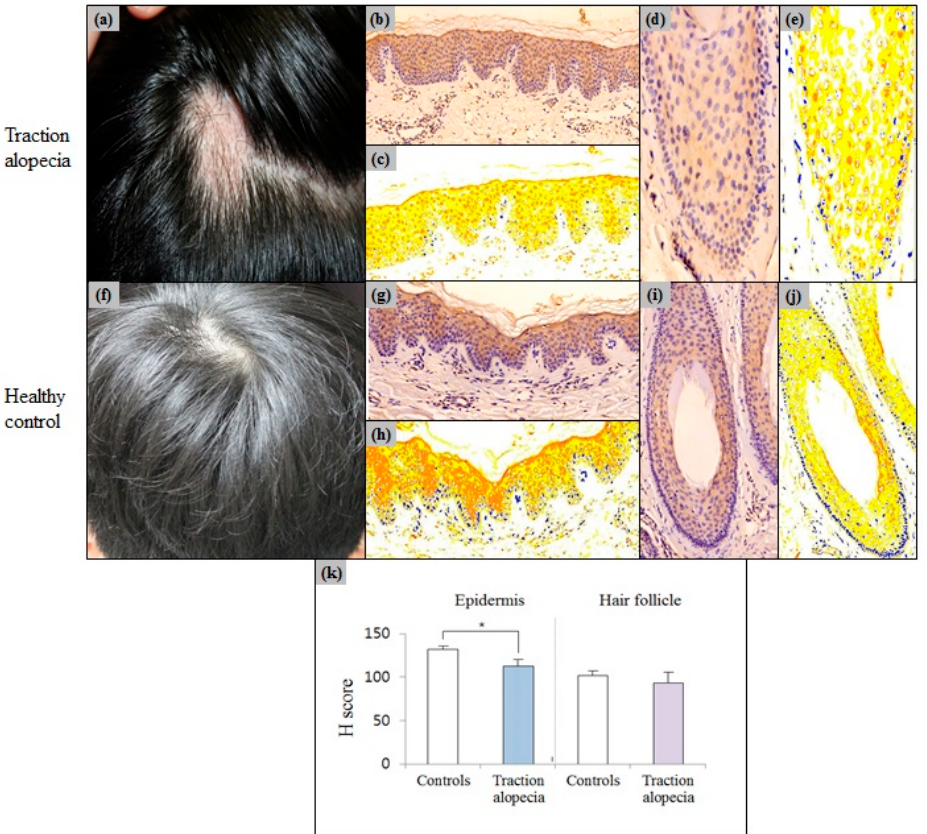
Figure 6. ( a ) Clinical photograph of traction alopecia; ( b ) Erdr1 staining patterns of the epidermis in traction alopecia; ( c ) HistoQuant™ measurement for the intensity of epidermal Erdr1 expression in traction alopecia patients; ( d ) Erdr1 staining patterns of the hair follicle in traction alopecia; ( e ) HistoQuant™ measured the intensity of Erdr1 expression in the hair follicles; ( f ) Clinical photograph of a healthy control; ( g ) Erdr1 staining patterns of the epidermis in healthy control; ( h ) HistoQuant™ measurement for the intensity of epidermal Erdr1 expression in the healthy control; ( i ) Erdr1 staining patterns of the hair follicle from the healthy control; ( j ) HistoQuant™ measurement for the intensity of Erdr1 expression in hair follicles; ( k ) The intensity of Erdr1 expression in traction alopecia was quantitatively determined using the HistoQuant™ H score and compared to that in healthy controls; Erdr1 immunostaining, original magnification ( b , c , g , h ) ×200; ( d , e , i , j ) ×400; * indicates a p -value less than 0.05.